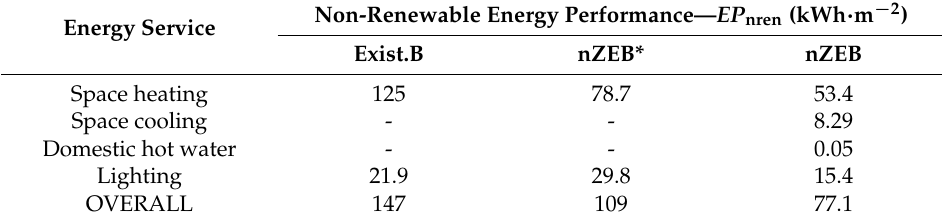
Table 10. Building energy performance ( EP